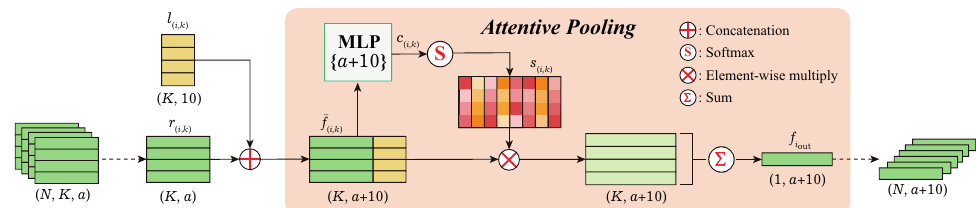
Figure 8. Attentive pooling. K by a -dimensional relative features of N points are integrated in this module with the permutation